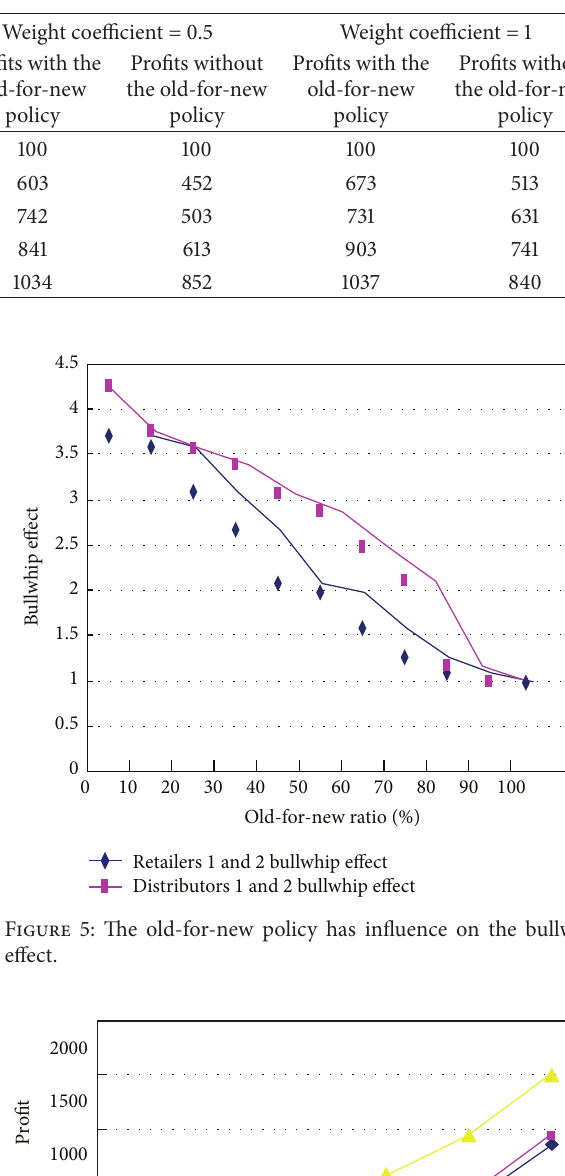
Table 3: The old-for-new policy has influence on the profit.